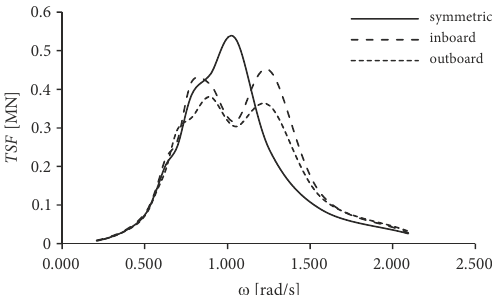
Figure 12. RAOs of transverse shear forces TSF in: a – beam seas; b – bow quartering seas